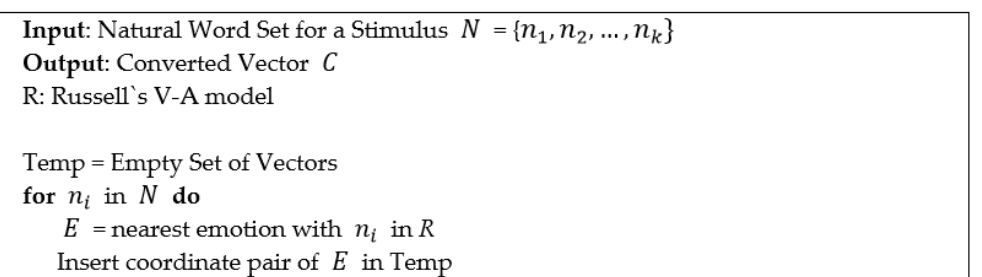
Figure 11. Natural word conversion algorithm.